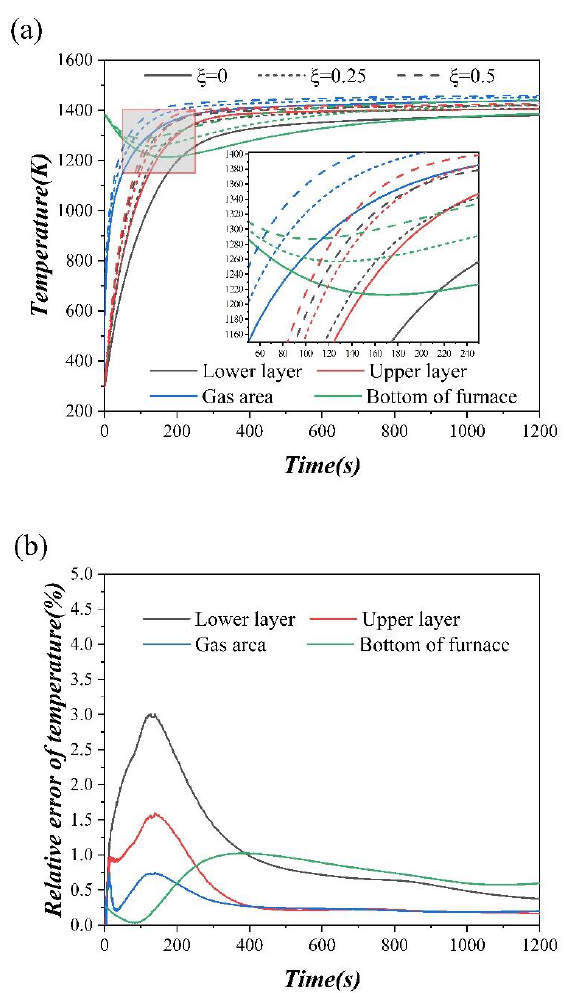
Figure 14. Influence of offset ξ on the temperature of the key bed parts. ( a ) Temperature curve. ( b ) Error curve.